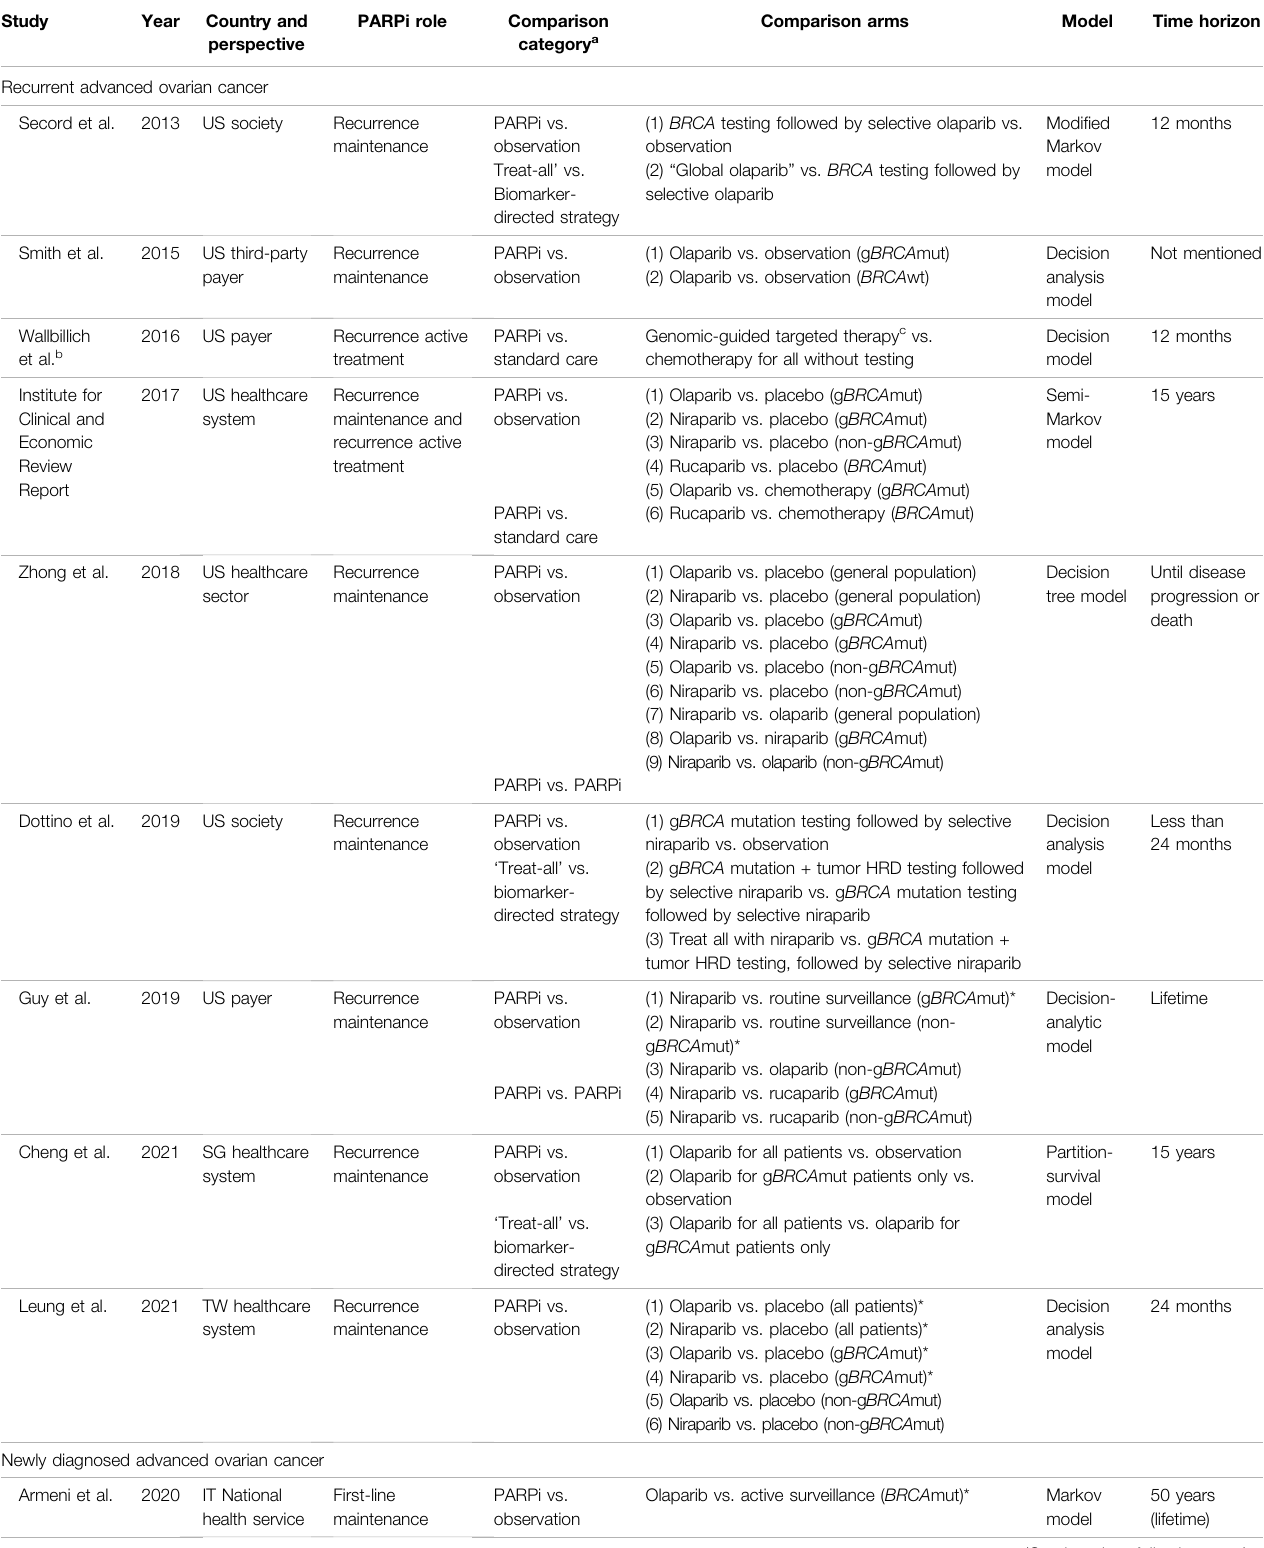
TABLE 1 | Characteristics of included studies by